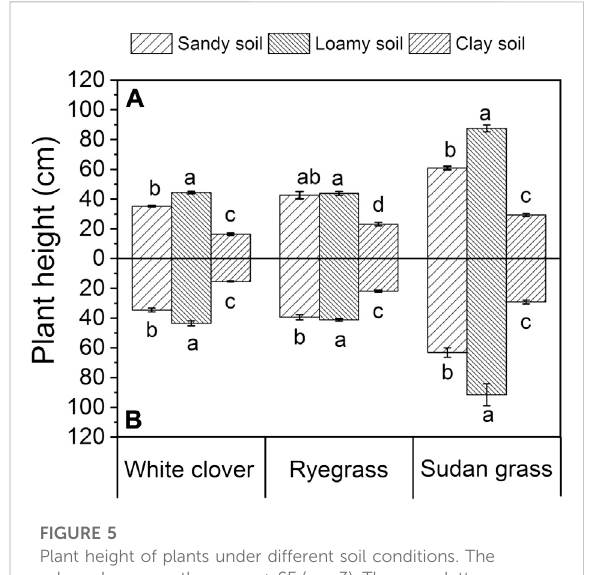
FIGURE 6 Plant biomass under different soil conditions. The values shown are the mean ± SE ( n = 3). The same letters among speci fi c treatments are not signi fi cantly different according to Duncan ’ s (0.05). Thus, (A) : treatment without glycine; (B) : treatment with